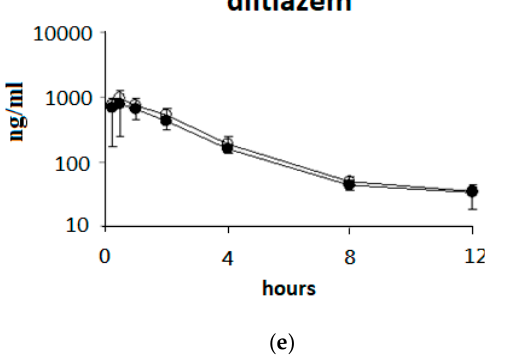
Figure 4. Plasma concentration–time profiles of five drugs (PO dosing) after the oral administration of soybean oil or the ABO-containing diet for 7 days in rats. The drug cocktail (CYP1A2: theophylline ( a ), CYP2C: diclofenac ( b ), CYP2D: dextromethorphan ( c ), CYP2E1: chlorzoxazone ( d ), CYP3A: diltiazem ( e ) was administered orally at a dose of 5–40 mg/kg BW to rats. Values at each time point are expressed as the mean ± SD of six rats in each group. ● : Control group; ○ : ABO group.